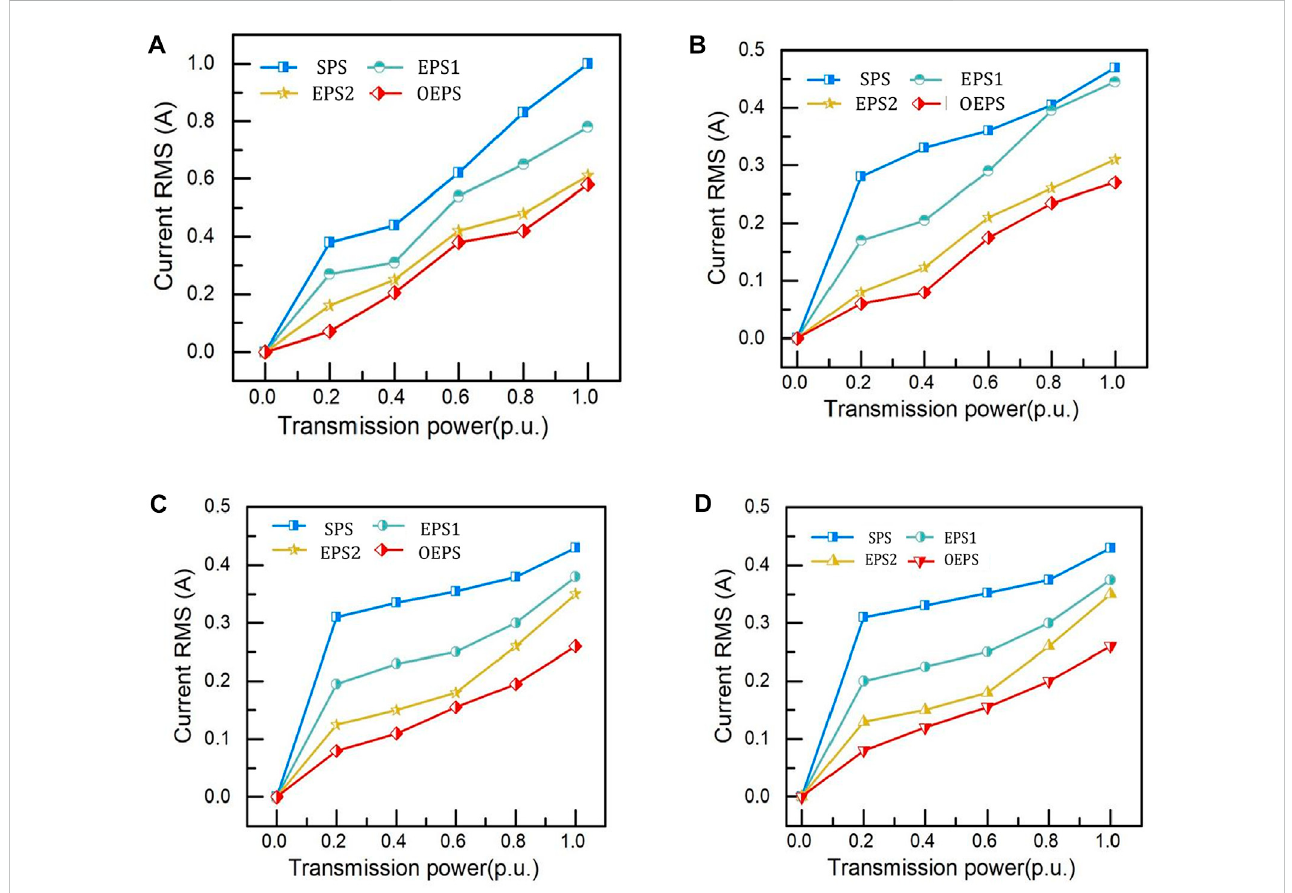
FIGURE 6 The Comparison of current RMS values under different modulation strategies and k : (A) k = .25; (B) k = .5; (C) k = 1; (D) k = 2.